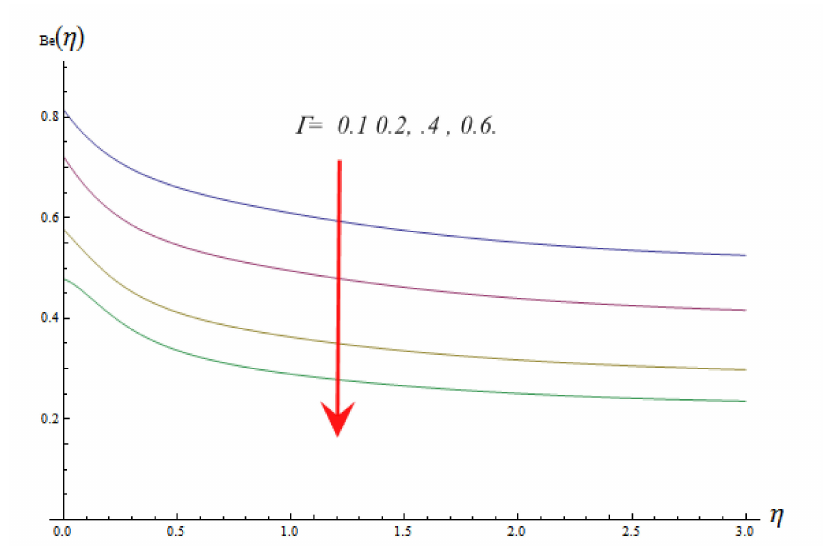
Figure 17. Sway of Γ on Be ( η ) , with Pr = 0.5, Ha = 0.2, Br = 2, λ = 2, Ec = 0.2, Rd = 2, β 1 = 0.2, λ 1 = 0.2, K ∗ = 2.